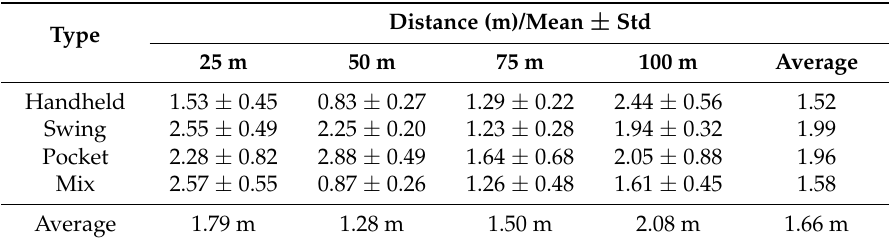
Table 2. Displacement Error of Corrected GPS Trajectory in Comparison with Ground Truth.